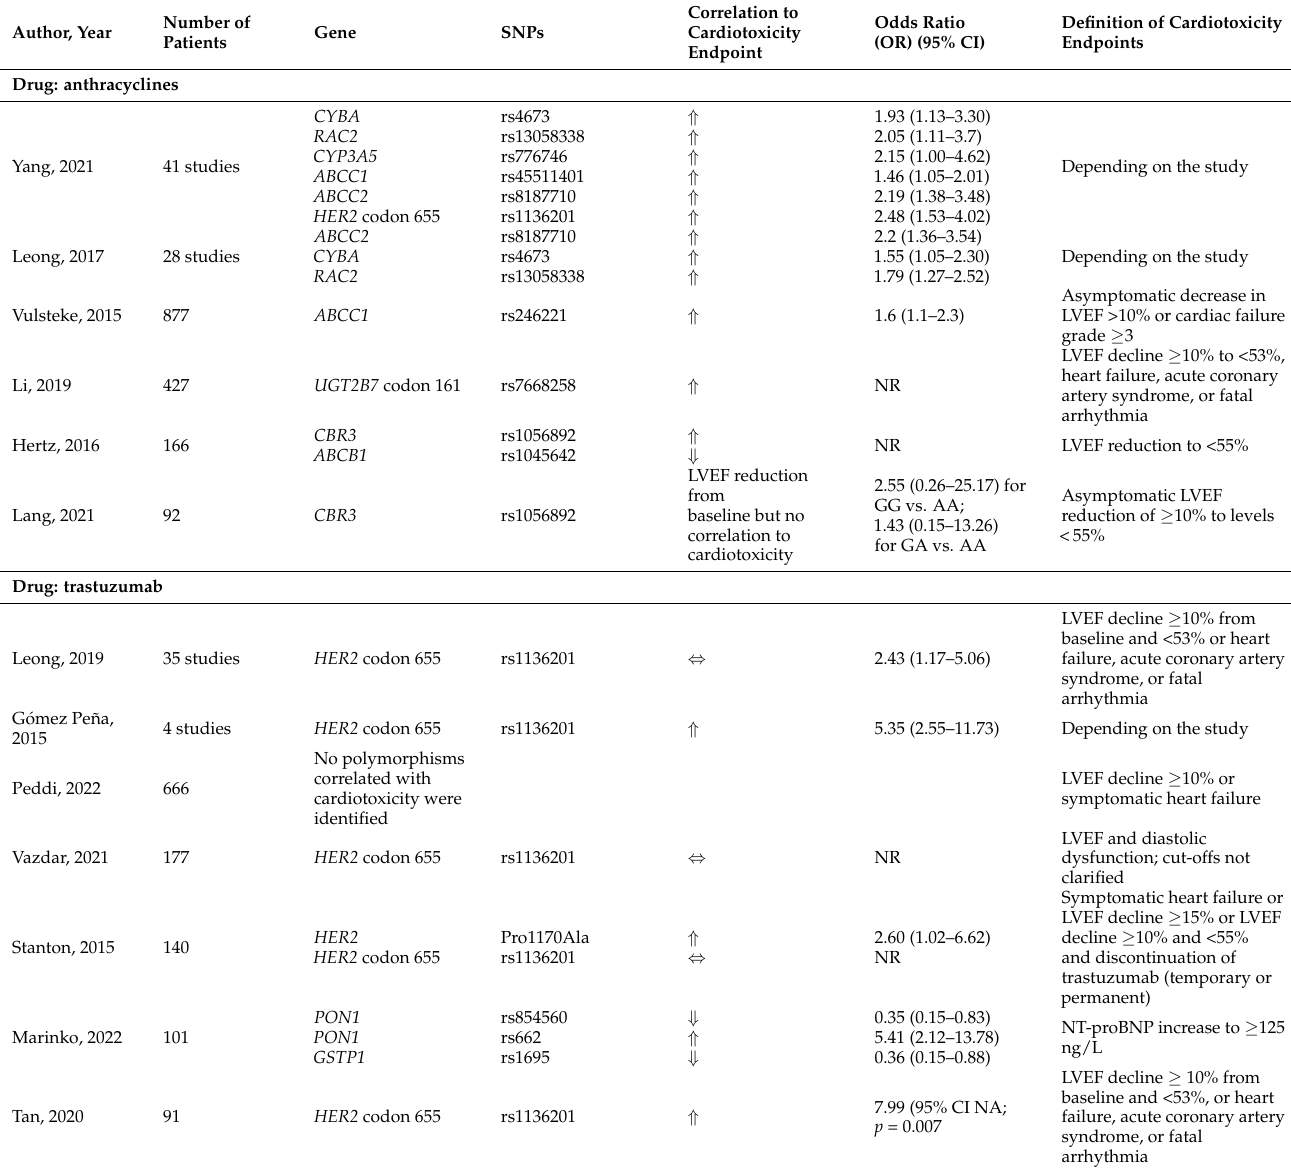
Table 1. Study characteristics, endpoint definition, and important findings in correlating genetic polymorphisms and risk for